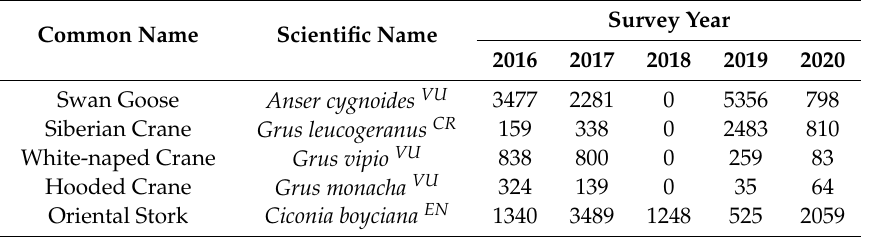
Table 2. Vulnerable and Endangered over-wintering aquatic bird species counts at each section of Poyang Lake between the years 2016 and 2020 in the winter season at the three study sites.